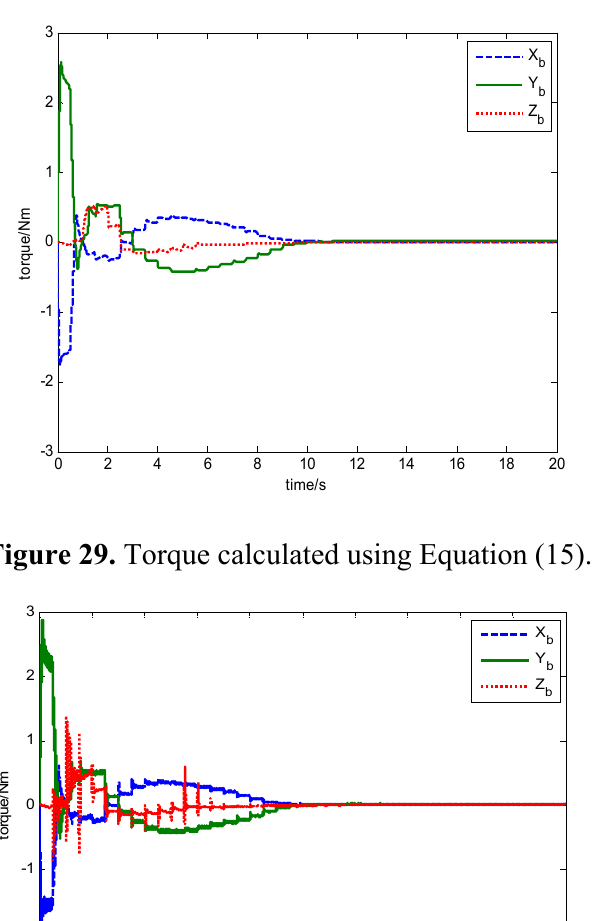
Figure 28. Torque calculated using Equation (19).